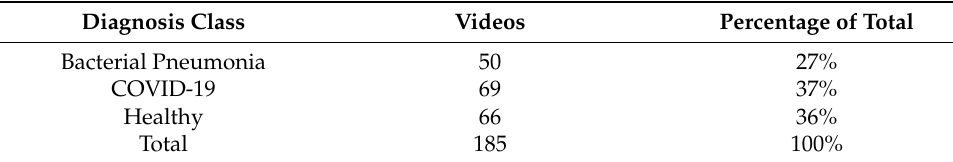
Table 1. Data of convex transducer US videos included in this